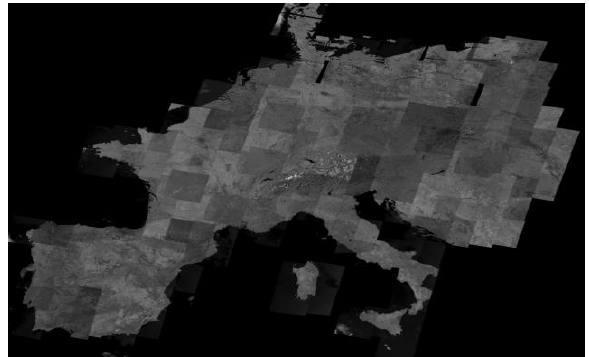
Figure 3. Color adjustment issue observed in Landsat visible image mosaic generated from Landsat 8 and GLS2010